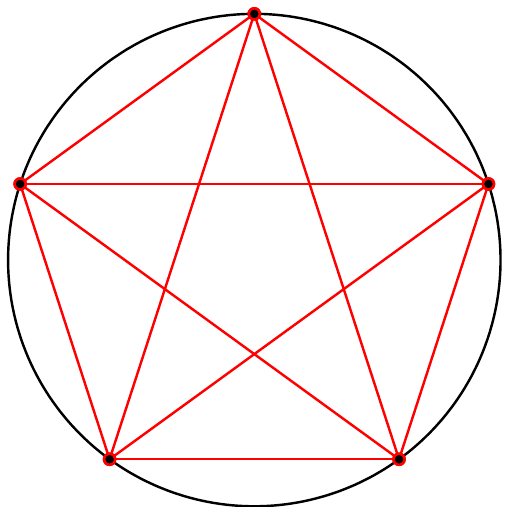
Figure 1 . Graphical representations of D-branes in the parafermion theory for k = 5 . J = 0 branes are located at 5 equidistant points on the circle, J = 1 branes are represented by the shorter lines 2 connecting the points and J = 1 branes by the longer lines. The second parameter n determines the angle of rotation of the